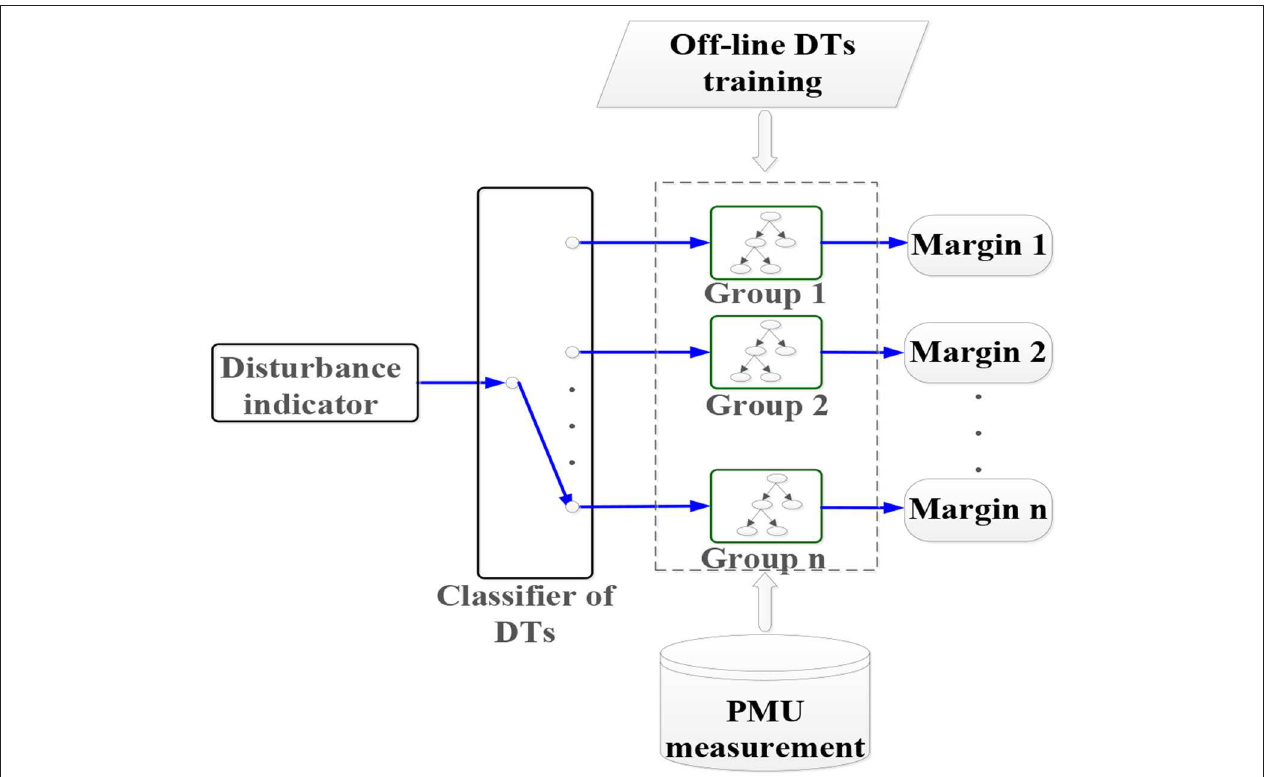
FIGURE 17 | Demonstration of applying